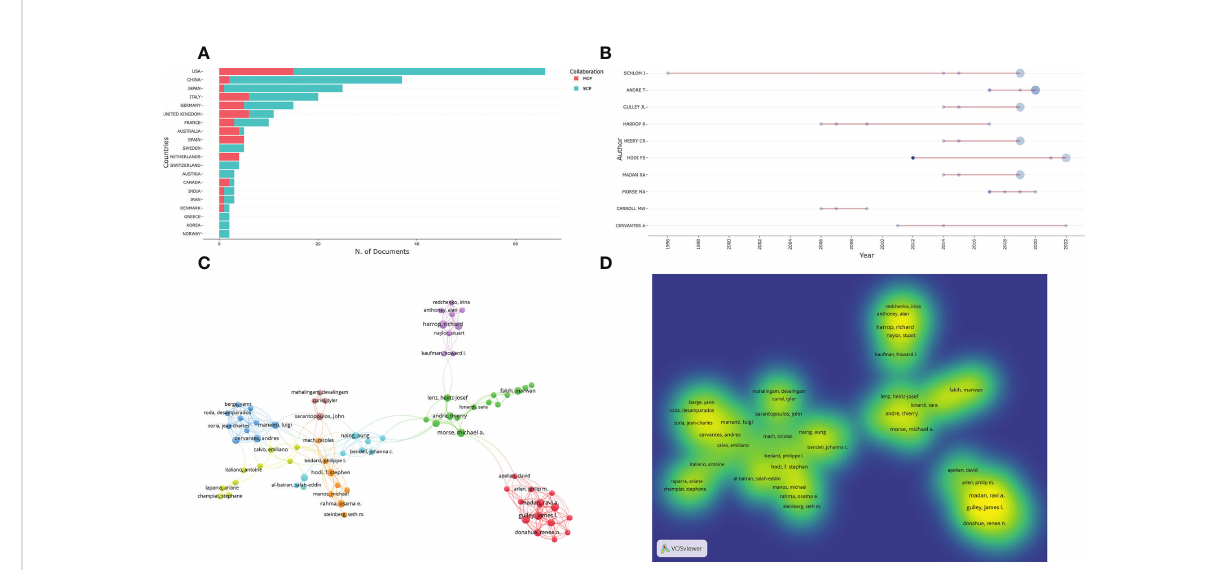
FIGURE 5 Authors contributing to IRAEs for colorectal cancer. (A) Nationality distribution of the contributing authors. (B) Distribution of the time of publication of the contributing authors. (C) Network map of co-authorship among authors who published more than 5 articles. (D) Distribution of co-authors according to the average frequency of occurrence. The keywords in yellow have the highest frequency of